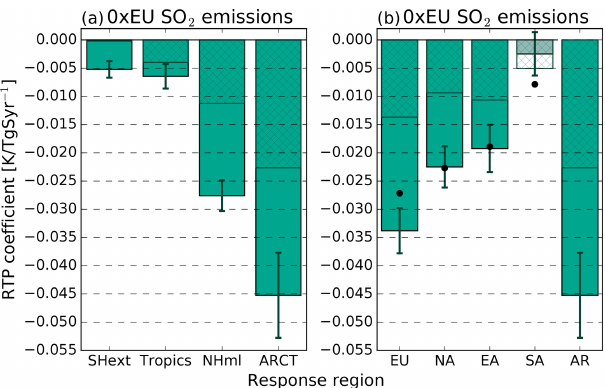
Figure 10. Latitudinal (a) and regional (b) RTP coefficients for 0 × EU SO 2 emissions (K(TgSyr − 1 ) − 1 ). Grey shading indicates non-statistical differences ( p > 0 . 05). The hatching indicates the RTP for 7 × EU emissions (cf. Figs. 4 and 8) for easy comparison. The error bars show the standard